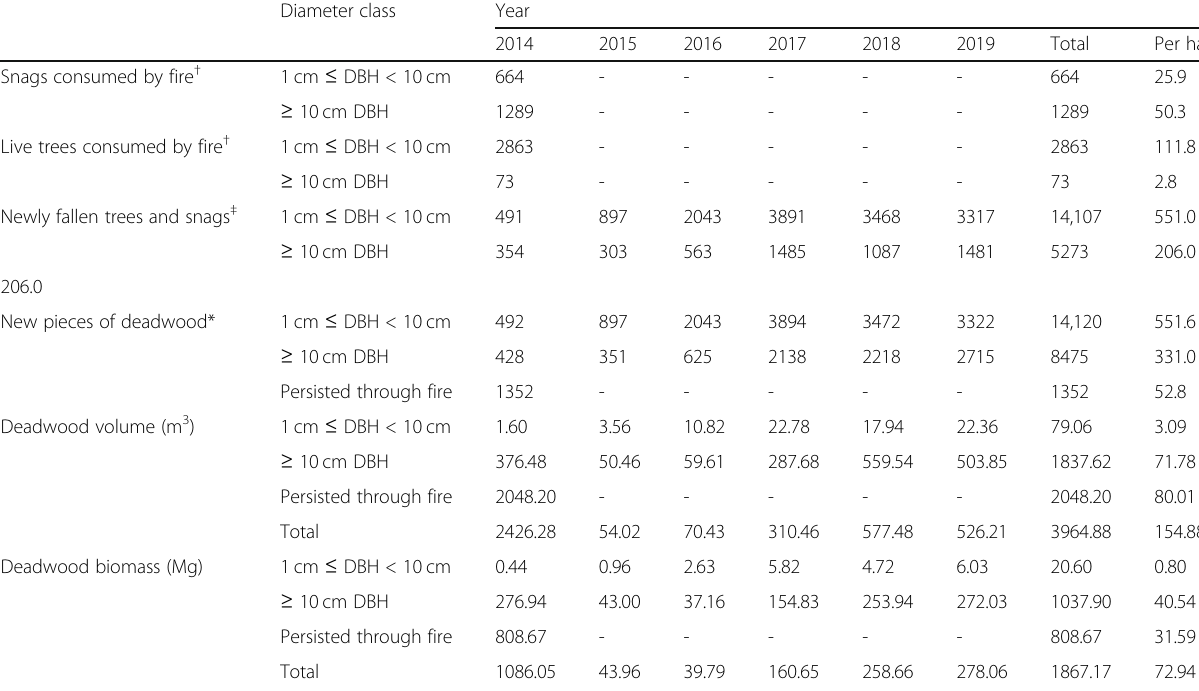
Table 1 Evolution of surface fuel immediately following fire (2014) and in the 5 years following in the 25.6-ha Yosemite Forest Dynamics Plot. The Rim Fire of 2013 directly consumed 12% of trees ≤ 10 cm DBH, but very few trees ≥ 10 cm DBH (0.5%). Most fire-killed trees and snags that persisted through the fire fell in subsequent years. For yearly progression of trees, snags, deadwood, recruitment, mortality, and snagfall, see Table